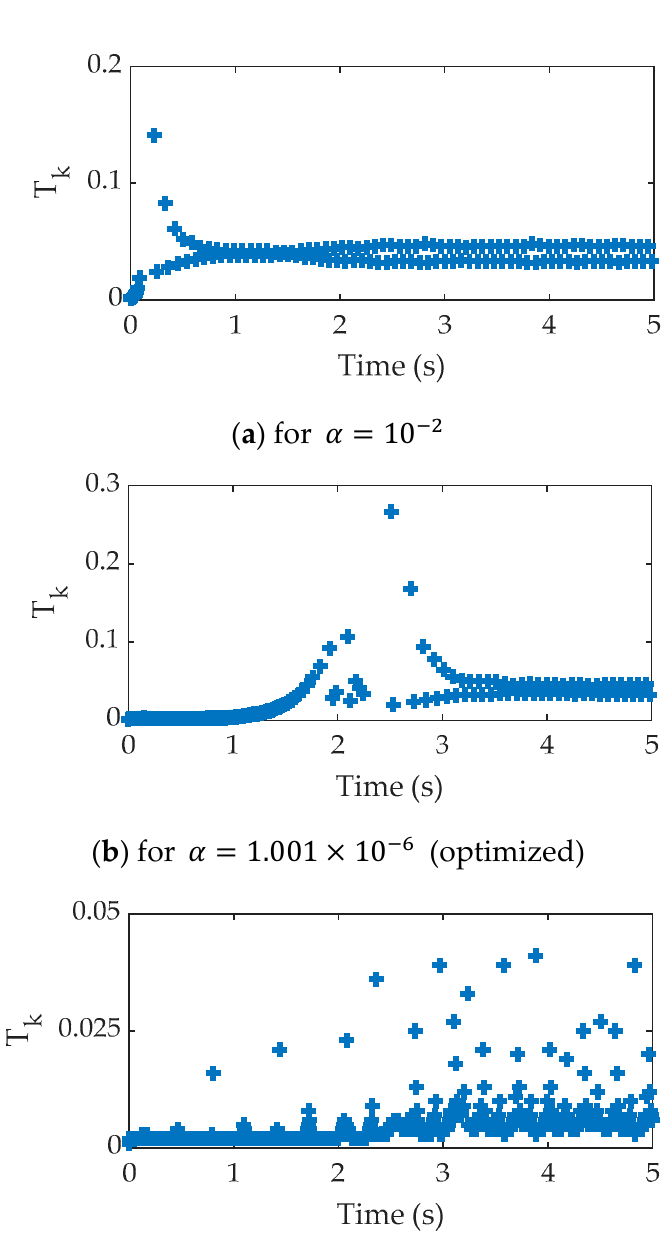
Figure 8. Inter event execution time, T k .